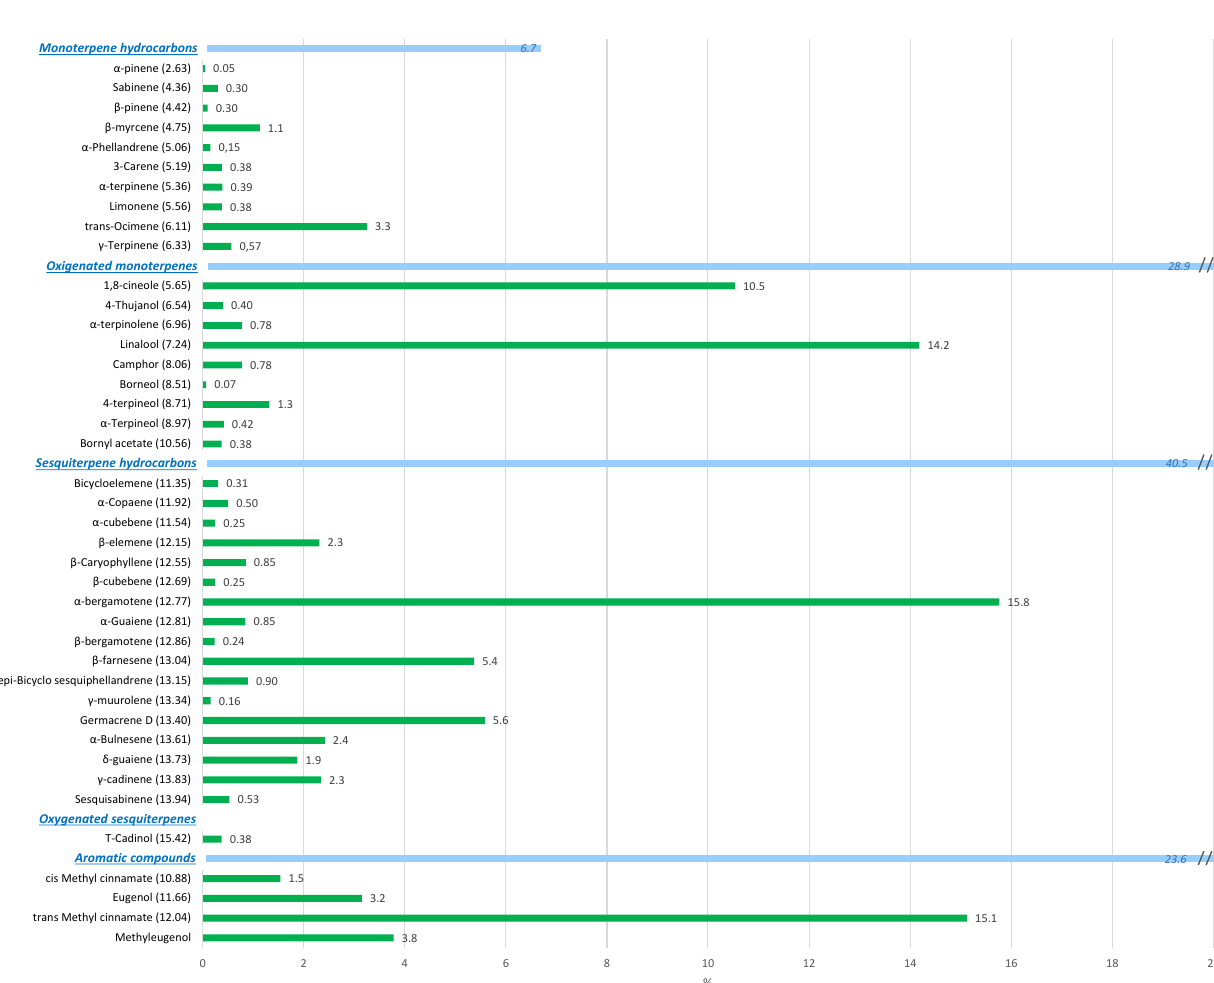
Figure 5. Volatile organic compounds (VOCs) profile of basil expressed as relative percentages. Bars represent relative VOCs contents (%). Values in parentheses represent VOCs retention times.